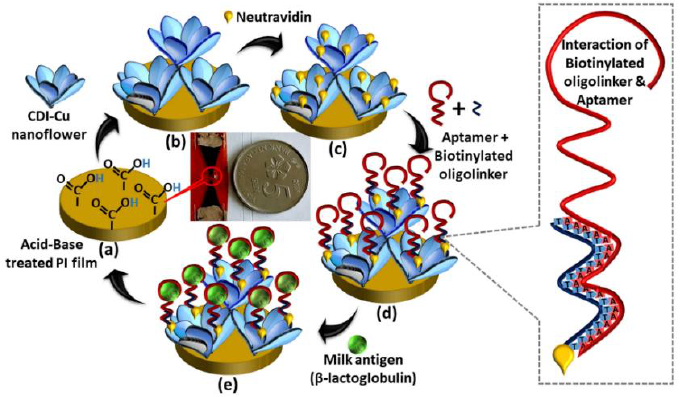
Figure 8. Stepwise realization of the β -LB aptasensor including polyimide (PI) film as the electrode substrate for LSGE, ( a ) acid – base treatment, ( b ) deposition of CDI-Cu hybrid NF, ( c ) modification with neutravidin, ( d ) immobilization of the aptamer, and ( e ) detection of β -lactoglobulin. Reprinted from [121] .